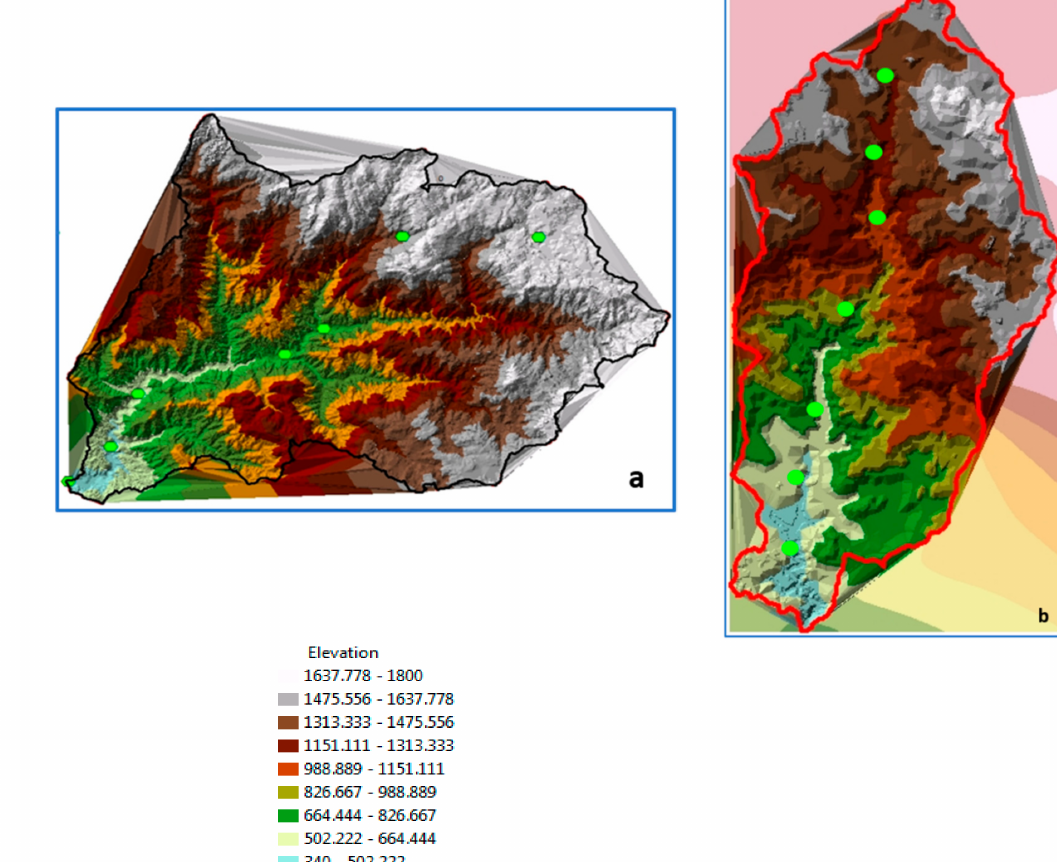
Figure 2. The elevation maps of the studied sub-watersheds: ( a ) Arkoudorema (ADR) and ( b ) Vathirema (VTR) along with the sampling stations (green